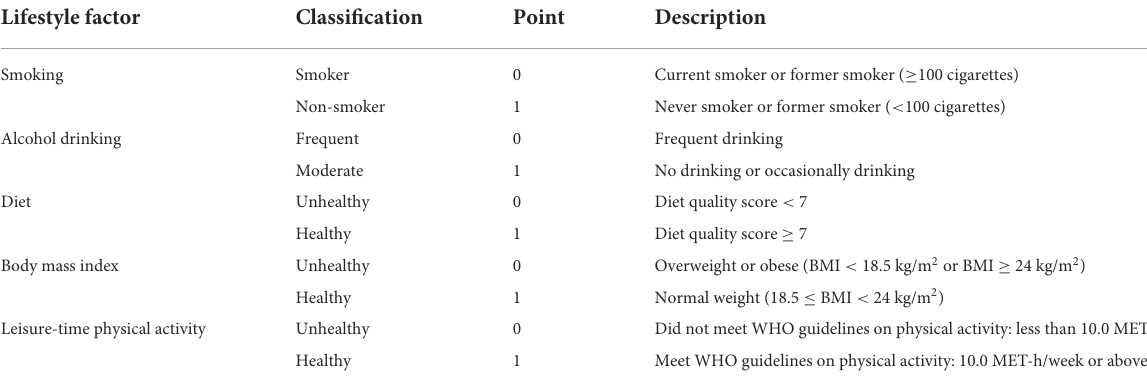
TABLE 1 Description and scoring criteria of lifestyle